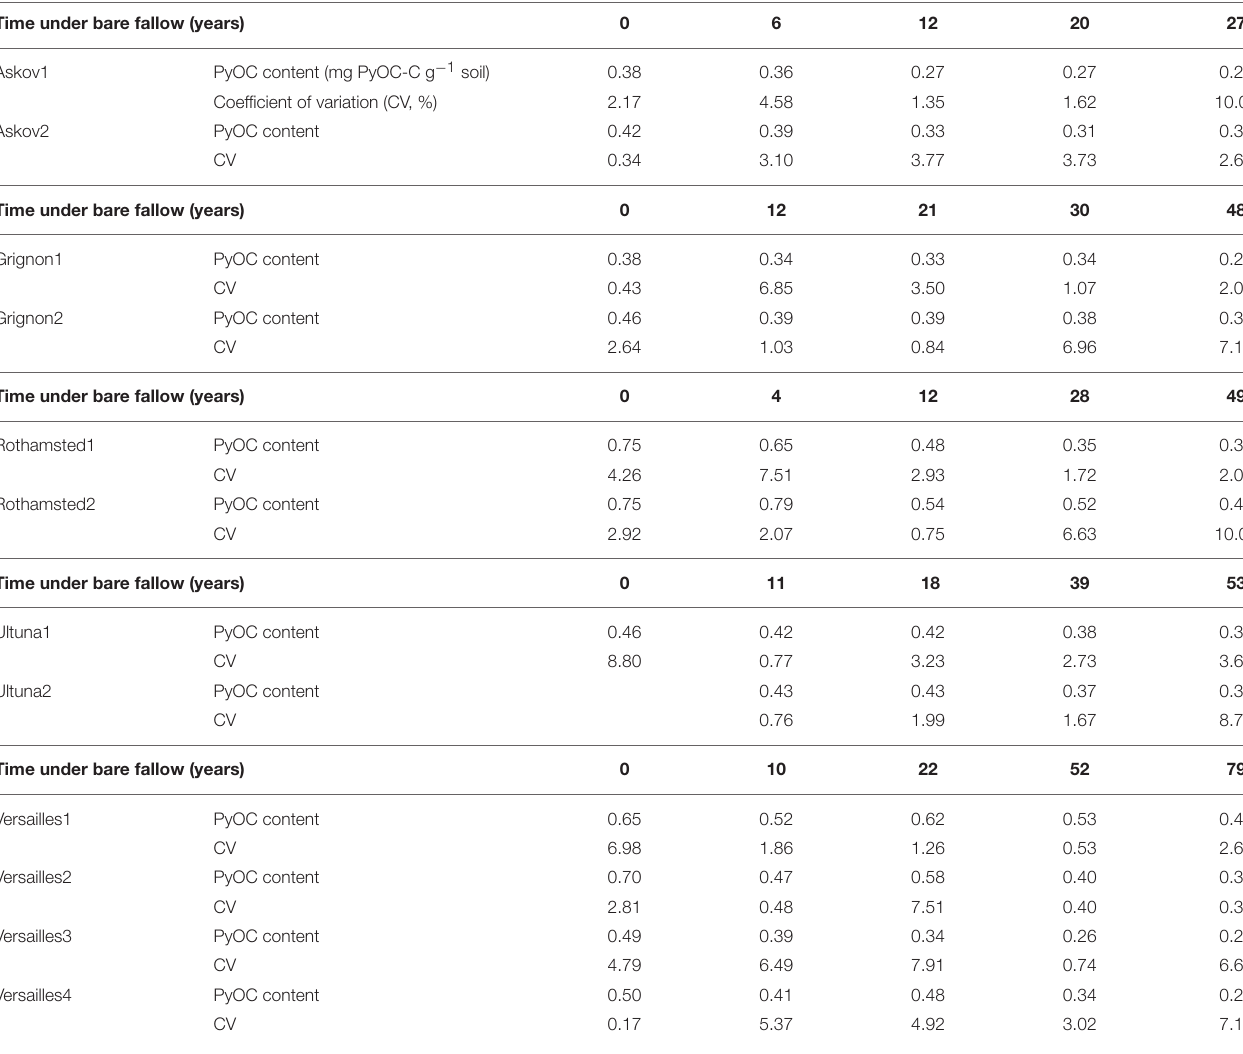
TABLE 2 | PyOC contents (mg PyOC-C g − 1 soil) measured by the BPCA method and coefficient of variation CV (%) for all samples and all sites. Time under bare fallow